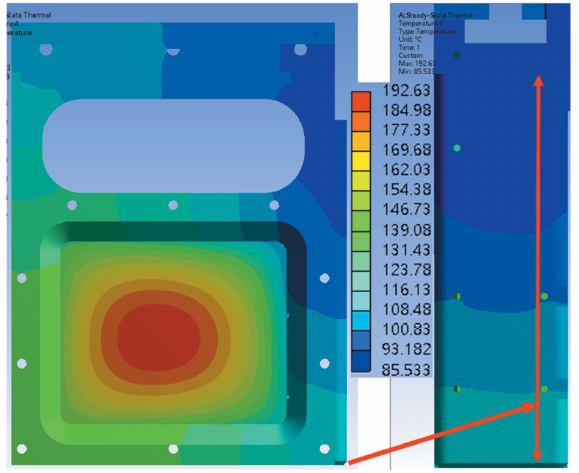
Figure 15 Numerical simulation results with for temperature distribution of the foil carrier and copper contact pad with a contact area of